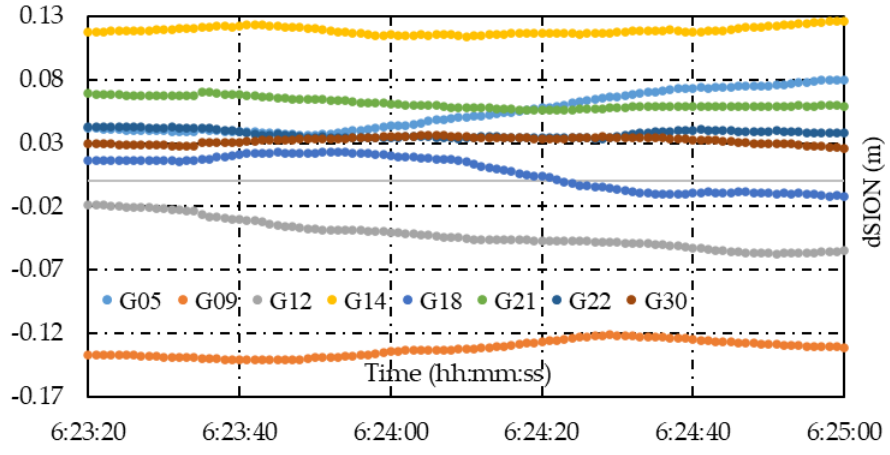
Figure 19. dSIONs between kinematic PPP without and with MSJP correction.